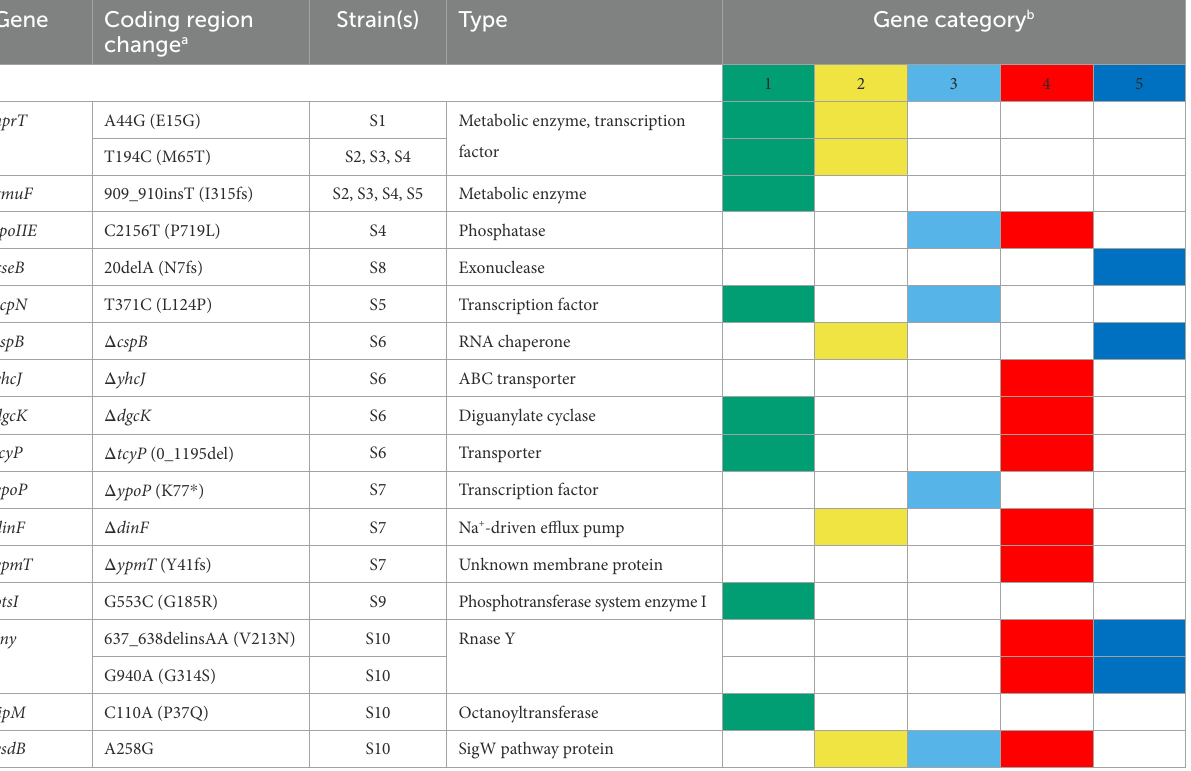
TABLE 3 Second-site suppressor mutations in dnaK tig double mutant